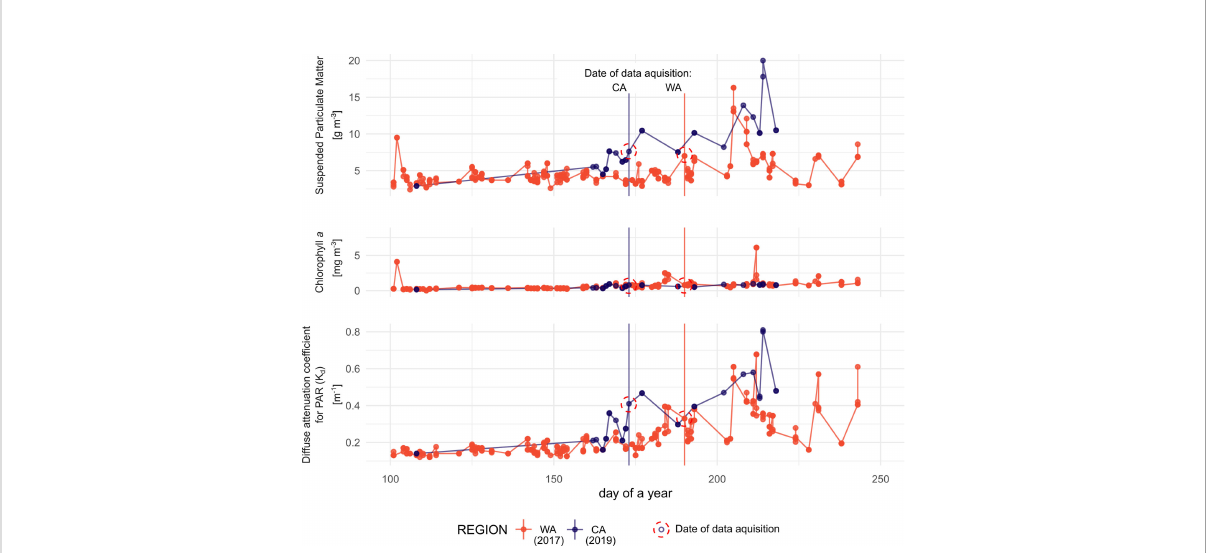
FIGURE 3 Time series of remotely derived parameters related to water transparency. Each series shows values from the year when the area was surveyed (2017 for WA and 2019 for CA). Day when in situ data were collected are indicated by vertical lines. Lack of data in case of CA in the spring is due to the ice and clouds obstructing the